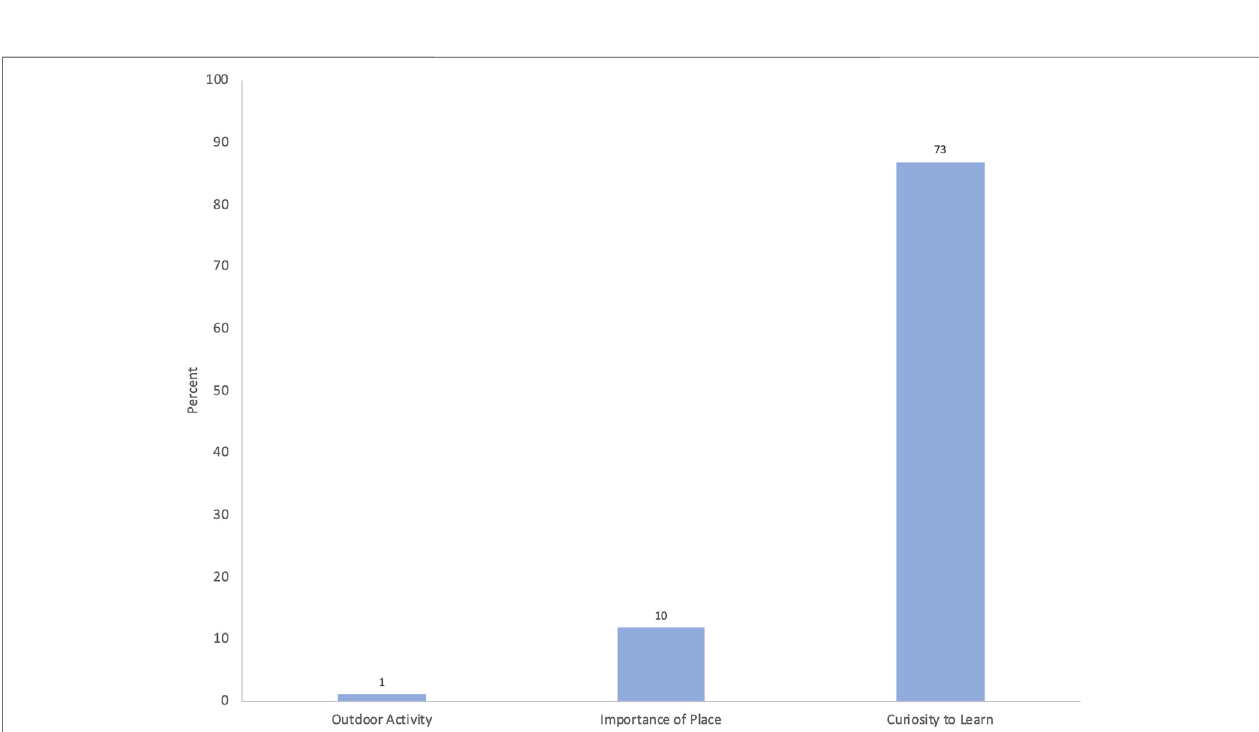
FIGURE 2 | Visitors interest prior to Mount Baldy hike ( n -84).